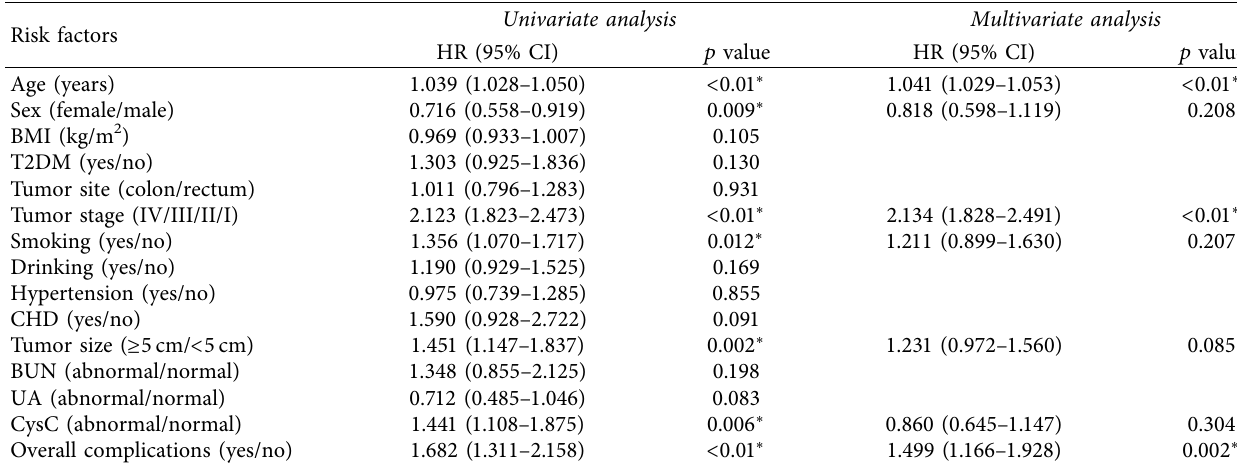
Table 4: Univariate and multivariate analyses of overall